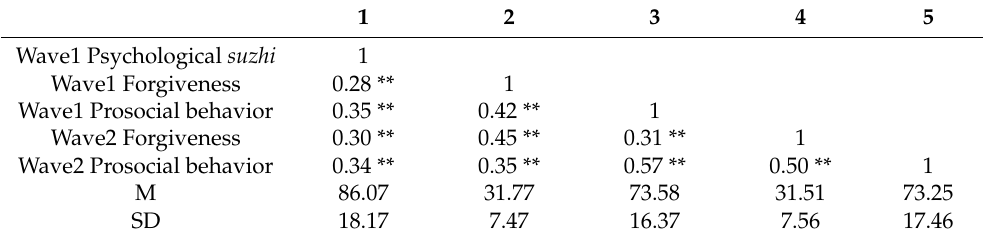
Table 1. Descriptive Statistical Analysis Among Main Variables (N = 477).